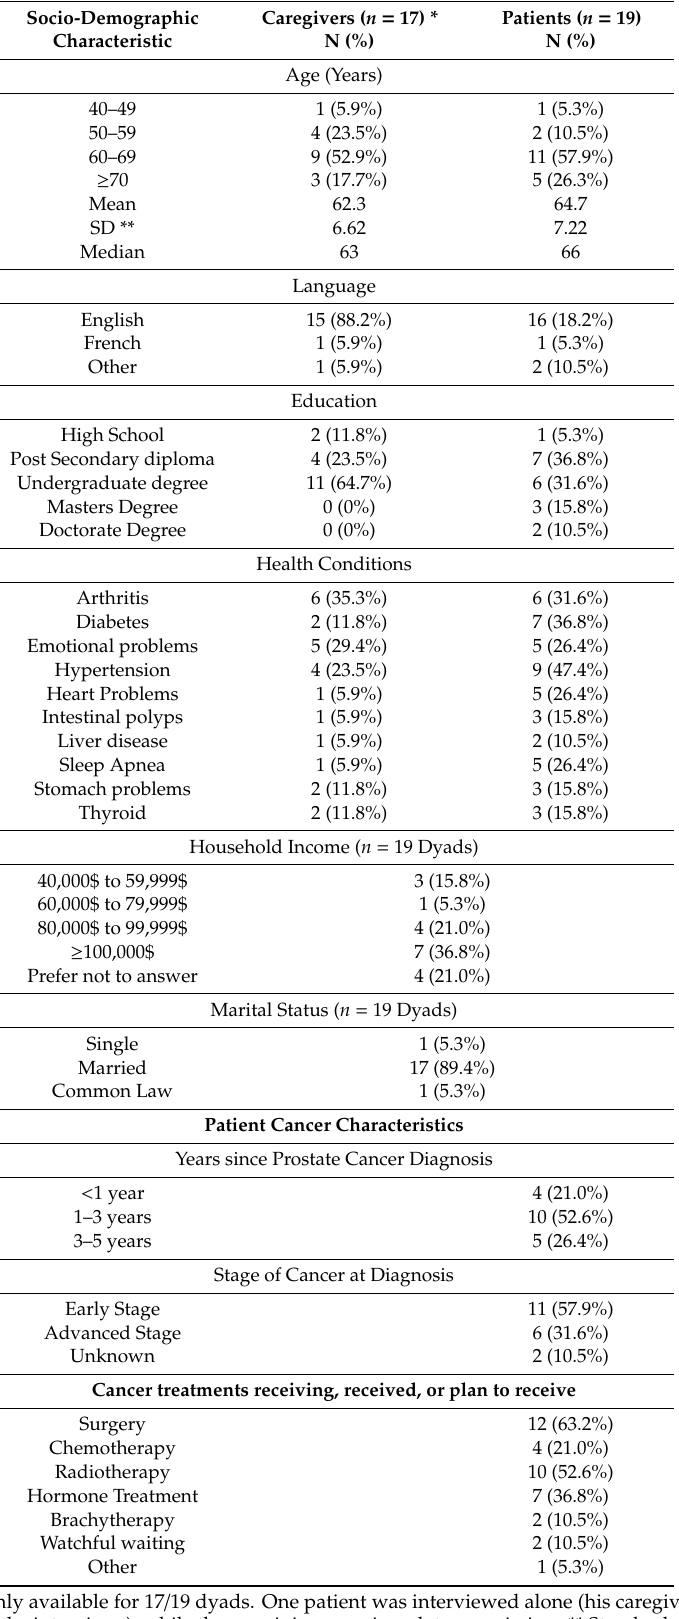
Table 1. Socio-demographic data for participant dyads ( n =